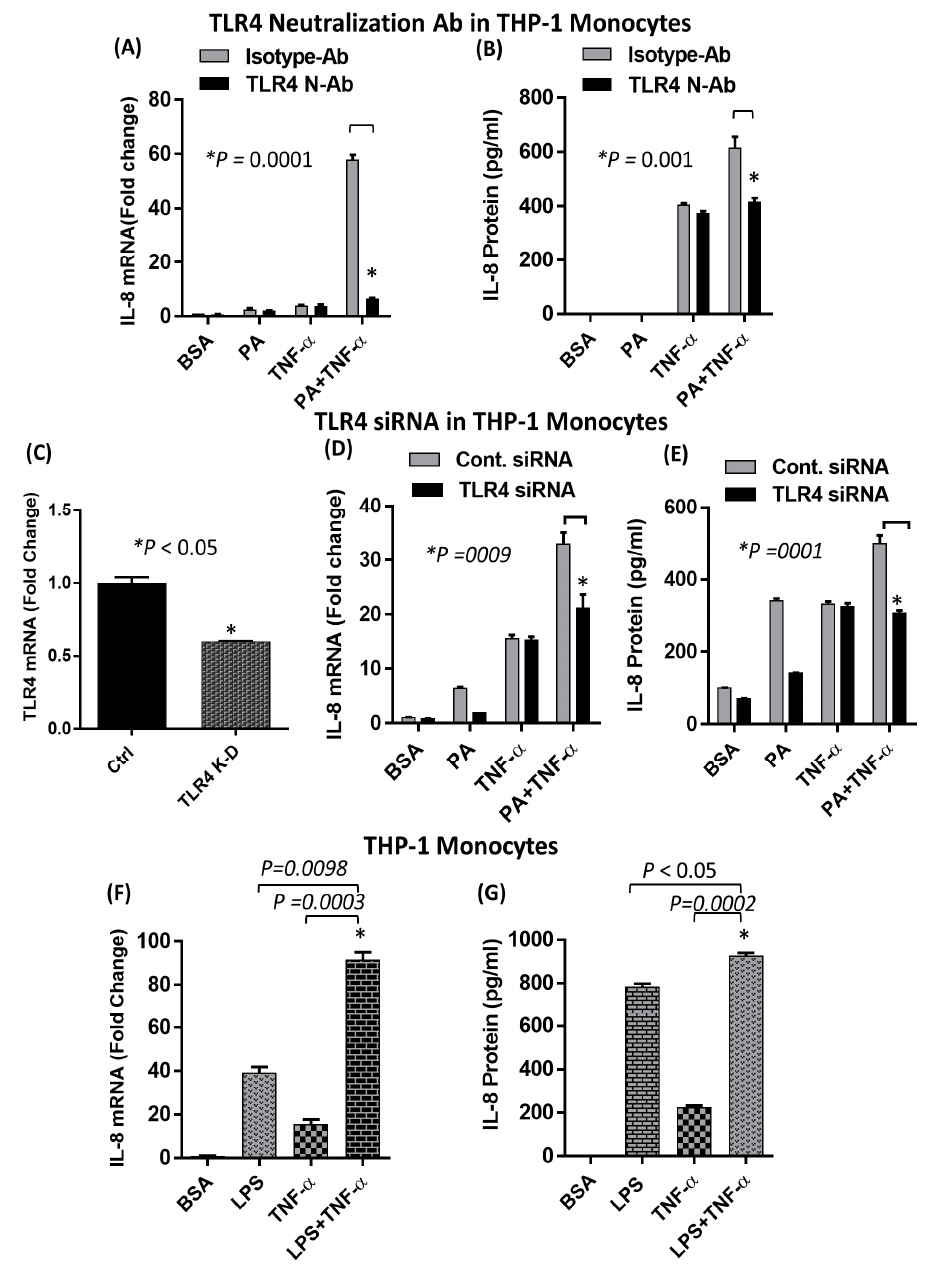
Figure 3. Interference of TLR4 suppresses the synergistic production of IL-8 . ( A , B ) Monocytes were treated with 2 µg/mL of neutralizing TLR4 mAb or isotype-matched control (IgA2) for 40 min. Antibody-treated cells were stimulated with palmitate, TNF- α or a combination of both and incubated for 24 h. IL-8 mRNA was quantified by real-time PCR and secreted IL-8 protein was quantified in culture media by ELISA. ( C ) Monocytes were transfected with either control or TLR4 siRNA. ( D , E ) Monocytes with TLR4-knockdown were treated with palmitate alone or in combination with TNF- α for 24 h. IL-8 expression was determined at both the mRNA and protein levels. ( F , G ) Monocytes were treated with lipopolysaccharide (LPS) alone or in combination with TNF- α for 24 h. IL-8 expression was determined at both the mRNA and protein levels. The results obtained from three replicates of each experiment are shown. Data are expressed as mean ± SEM. *Indicates significant difference